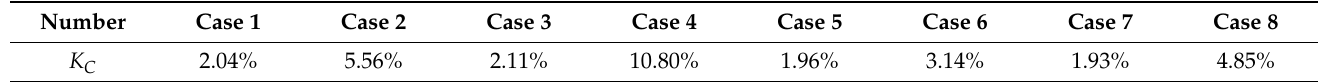
Table 7. Dispersion coefficient K C at various experimental conditions.